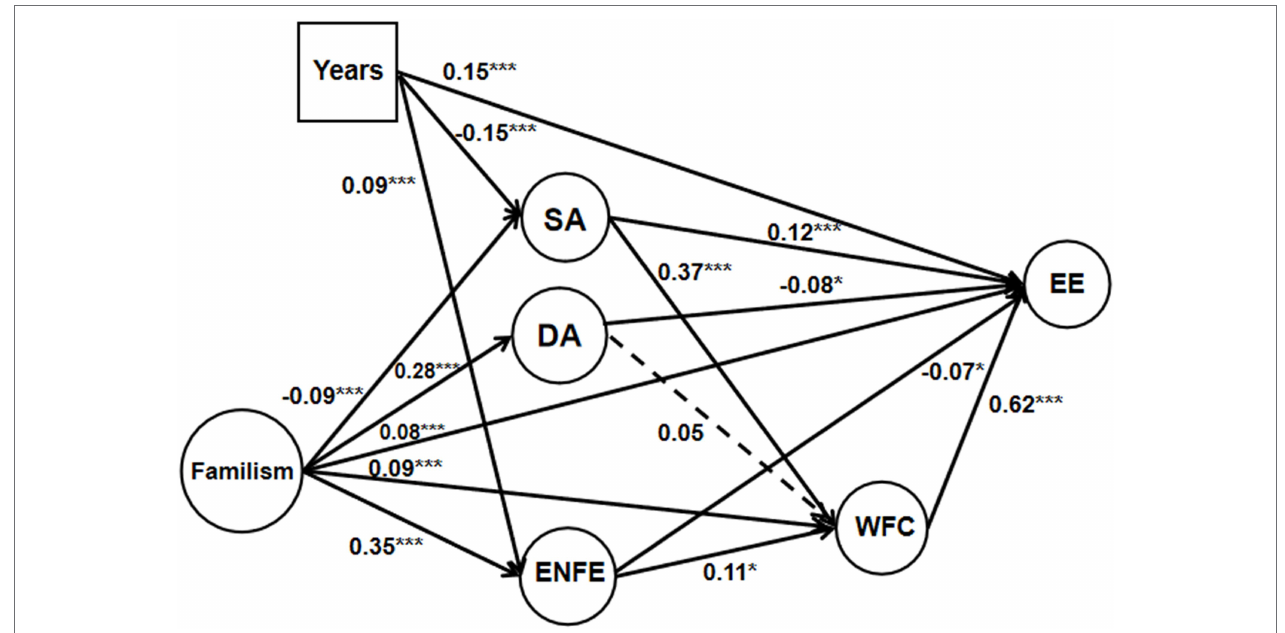
FIGURE 1 | The relationships between familism, EL, WFC, and EE, controlling for years of teaching experience (the solid line represents the significant path; the dotted line represents the insignificant path). * p < 0.05; *** p <